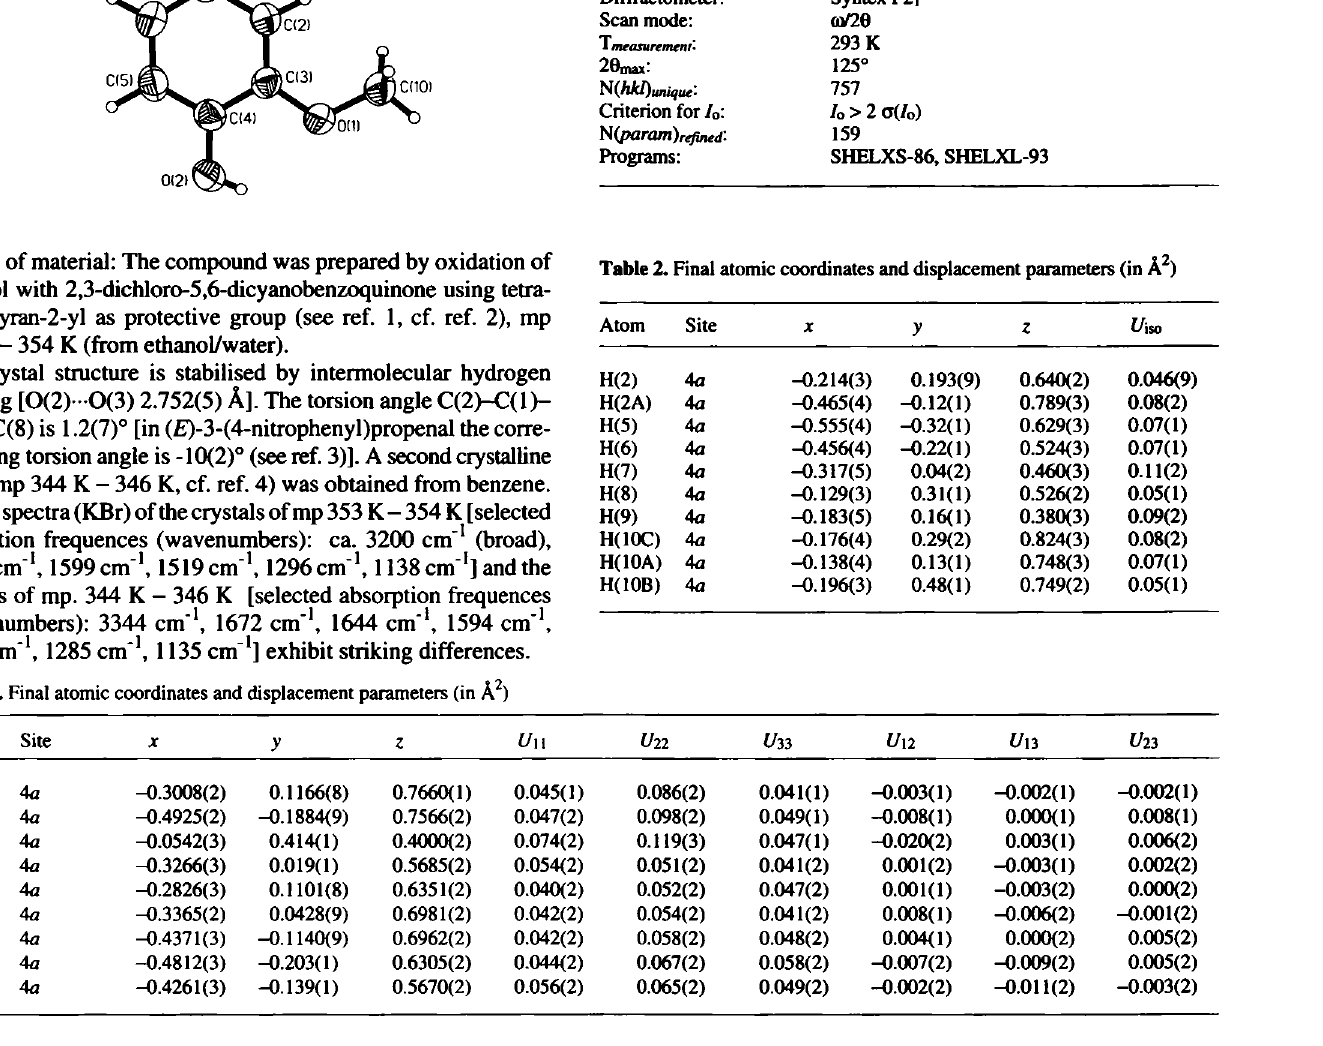
Table I. Parameters used for the X-ray data collection Crystal: